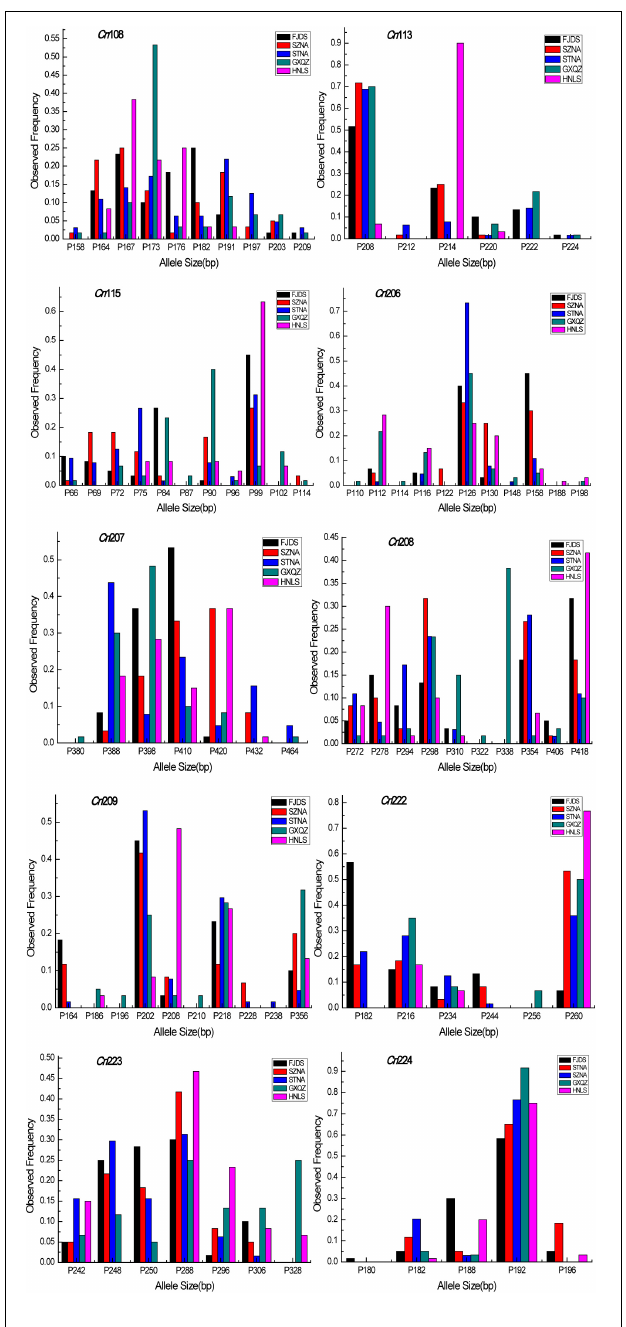
FIGURE 2 | Allele size frequency distributions of the 10 microsatellite loci in five C. nobilis populations in this study.